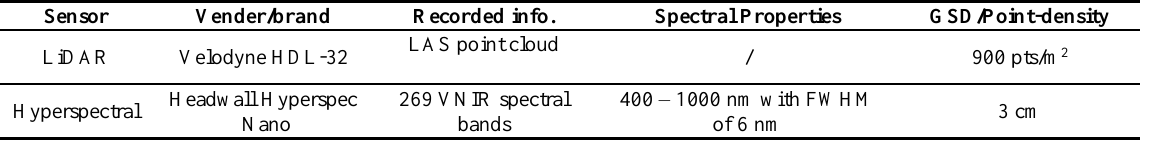
Table 1. List of Remote Sensing Platforms and